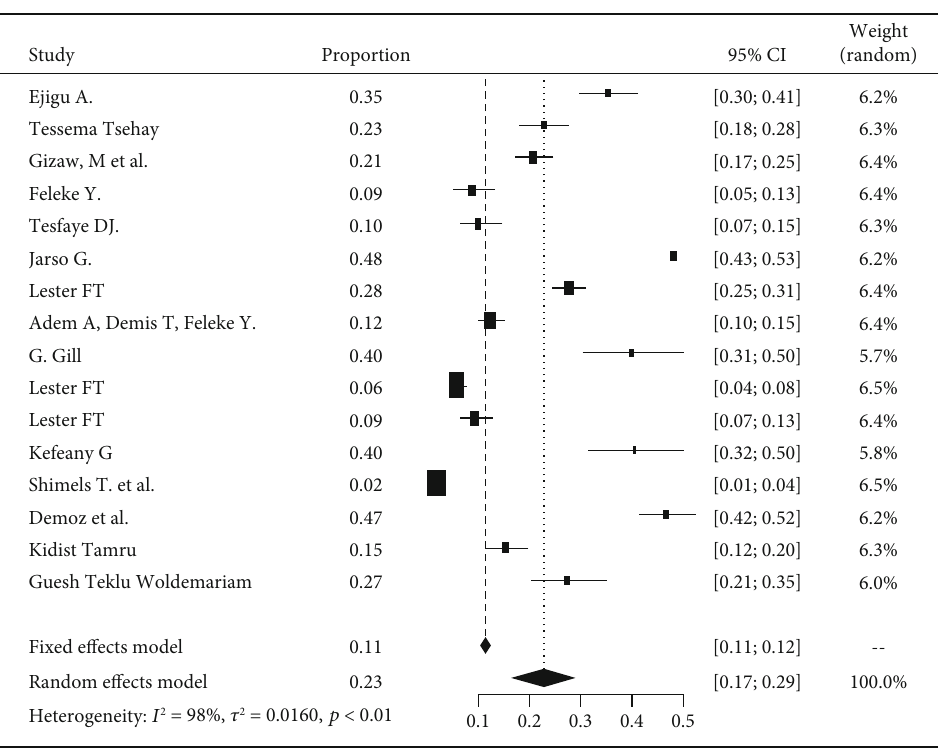
Figure 3: Funnel plot showing evidence of publication bias across studies.